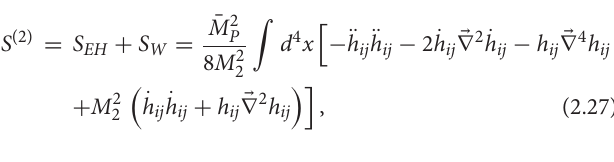
TABLE 1 | Degrees of freedom in the gravitational sector. Field Spin Mass Graviton 2 0 Ghost 2 M 2 Scalar ζ 0 M 0 The scalar ζ is due to the R 2 term in the Lagrangian; the dots in its mass M 0 represent the possible contribution of other scalars mixing with ζ (if any), which can be present in specific